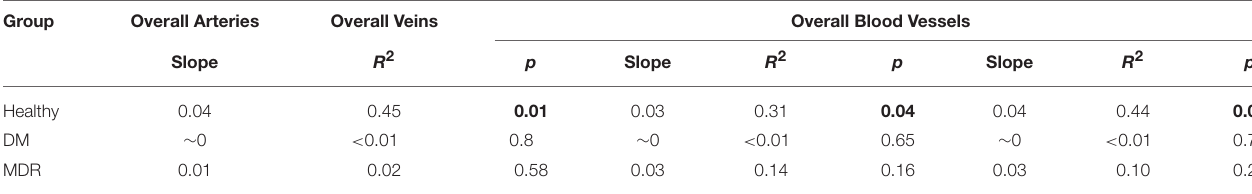
TABLE 3 | Linear regression results obtained for all three groups after analyzing the correlations between the FD and BFR. Significant results ( p < 0.05) are highlighted in bold. Group Overall Arteries Overall Veins Overall Blood Vessels